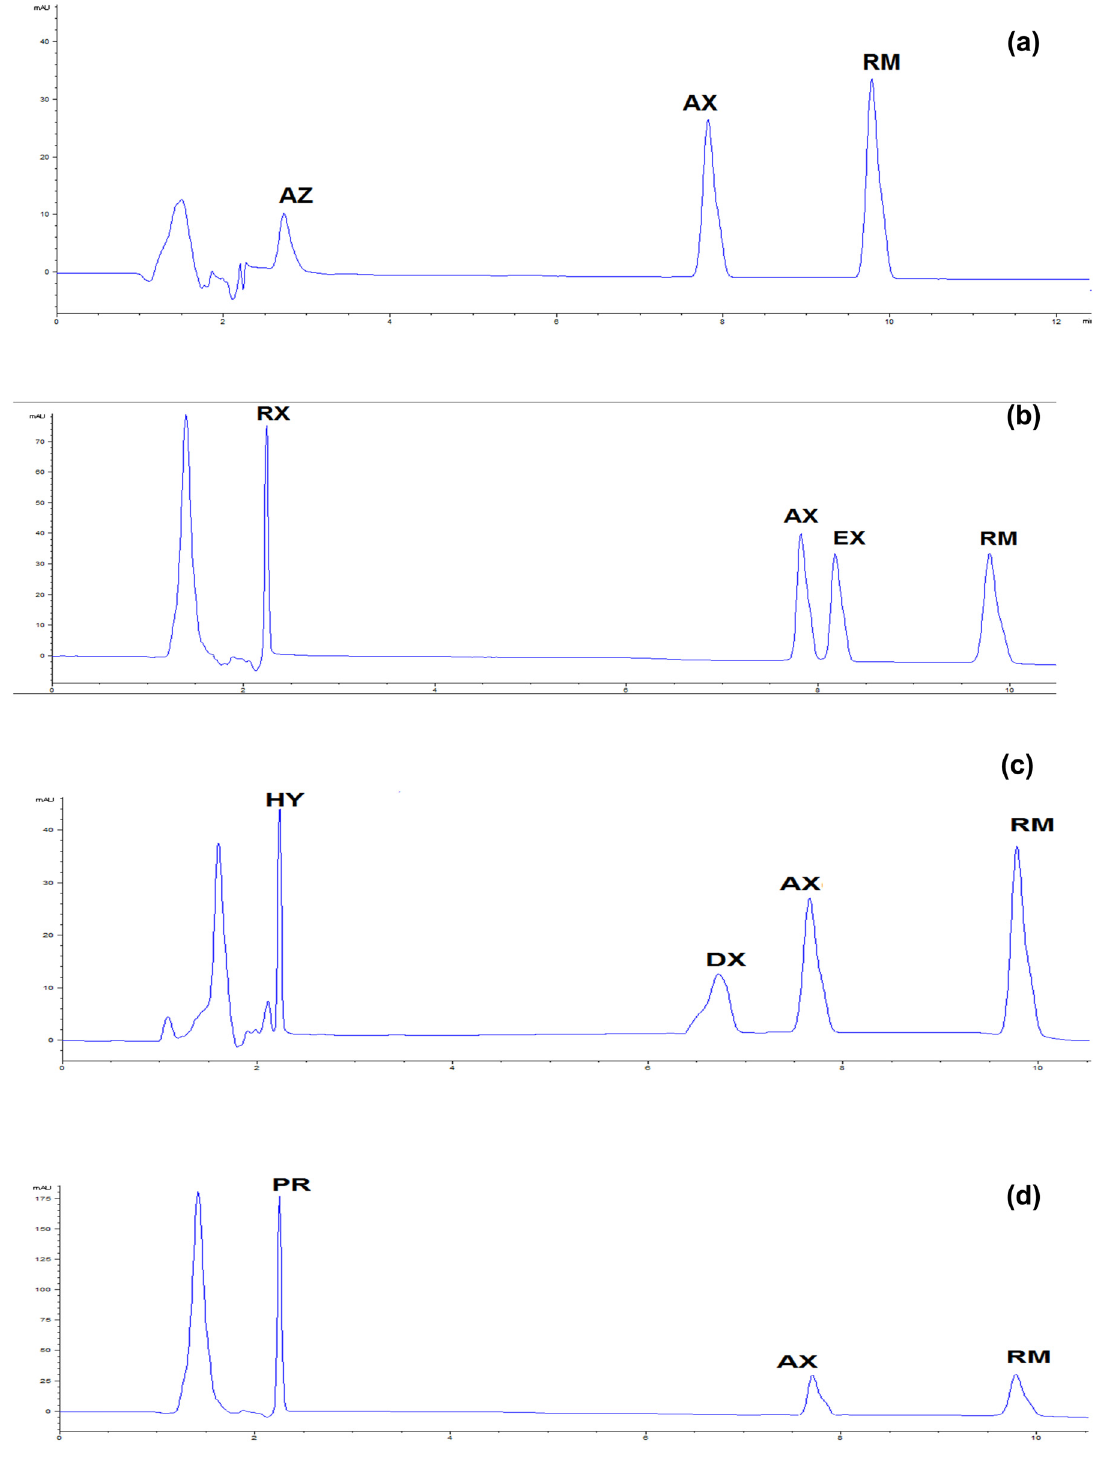
Figure 2: Representative HPLC - DAD chromatograms of extracted plasma samples spiked with RM ( 15 μ g · mL − 1 plasma ) and the co - admi - nistered drugs ( 10 μ g · mL − 1 plasma ) showing: ( a ) AZ; ( b ) AX, RX, and EX; ( c ) DX and HY; and ( d ) PR all with IS ( AX )